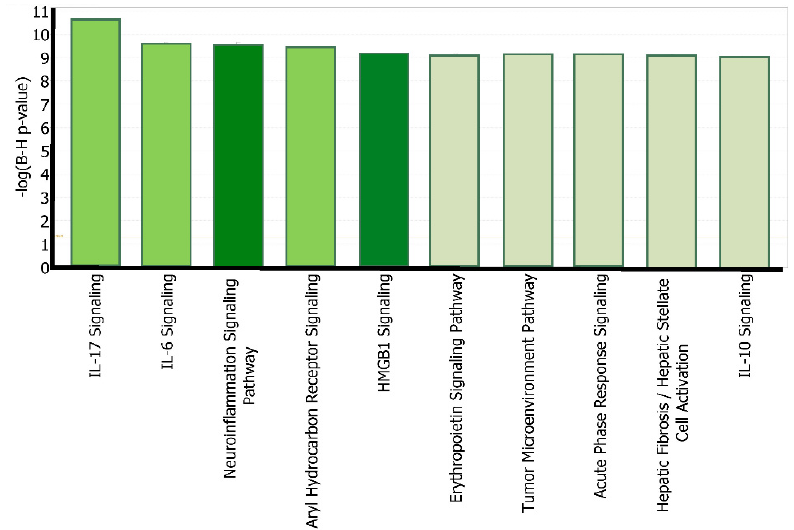
Figure 4. The core analysis of top canonical pathways. The core analysis of the 8 overlapping molecules (JUN, MAPK3, MMP9, IL6, IL1B, TNF, IL1, and IFG1R) identified a series of canonical pathways associated with the molecules, which are listed in order of decreasing –log(B-H p -value). The dark highlighted pathways, neuroinflammation signaling pathways, and HGMB1 signaling, were the ones chosen for further investigation of their role in Alzheimer’s disease.